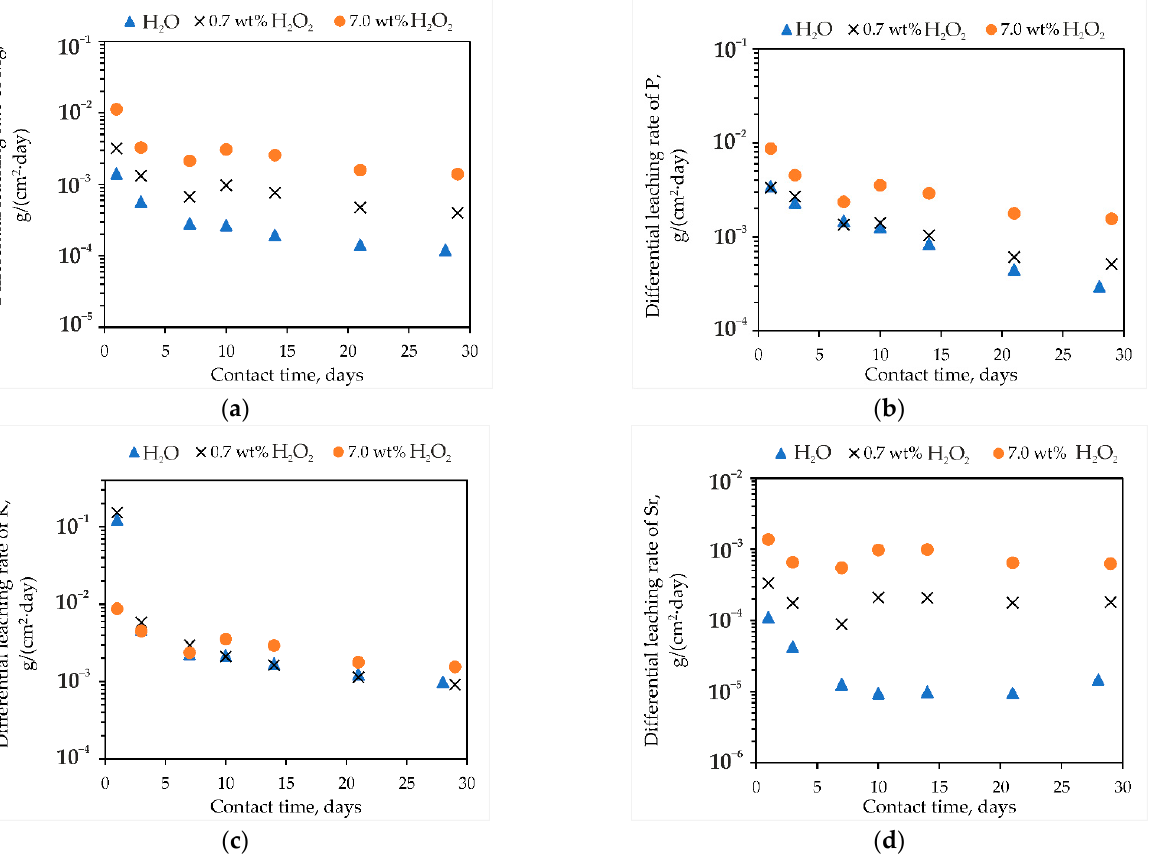
Figure 7. Kinetic curves of the leaching rates of ( a ) Mg, ( b ) P, ( c ) K, and ( d ) Sr from MPP-Z compound after its heat treatment at 450 °C as a function of the hydrogen peroxide content in the contact solution.